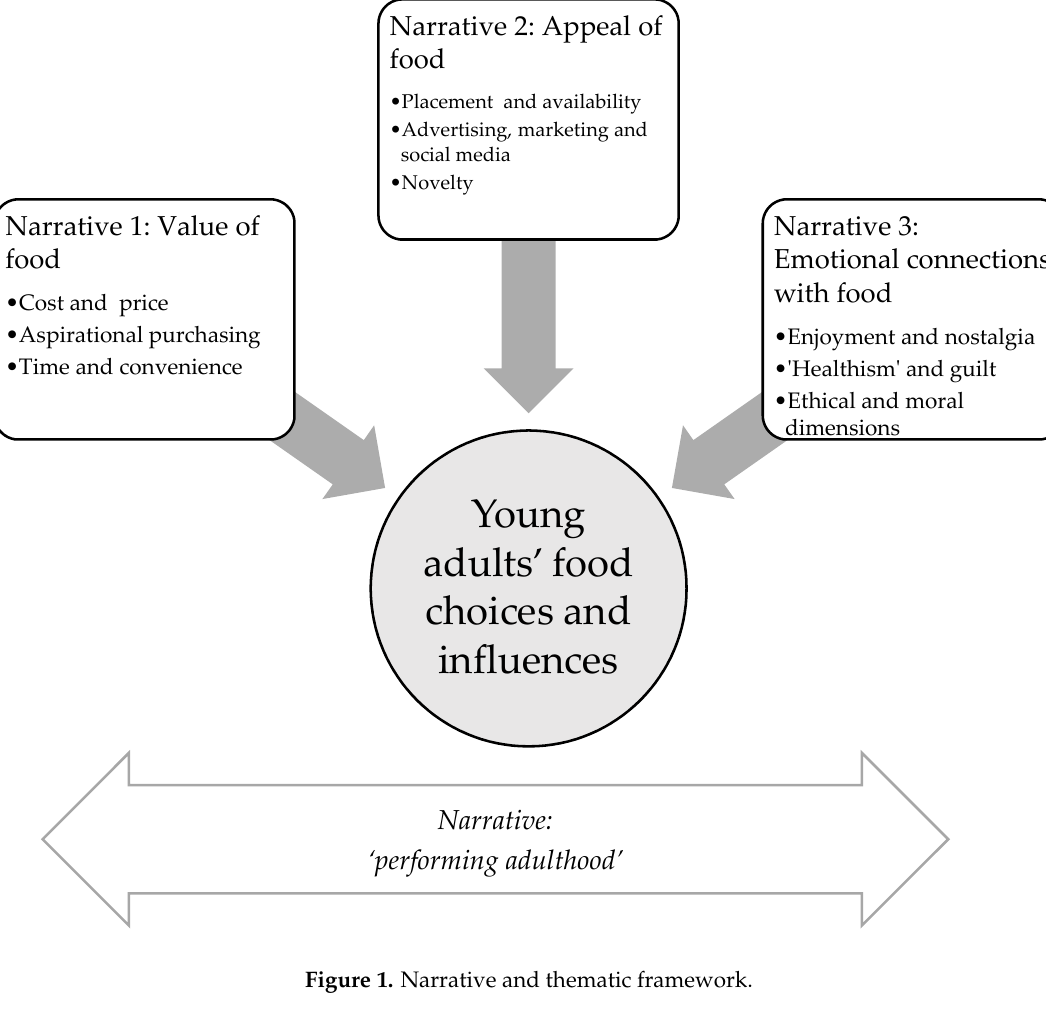
Figure 1. Narrative and thematic framework.